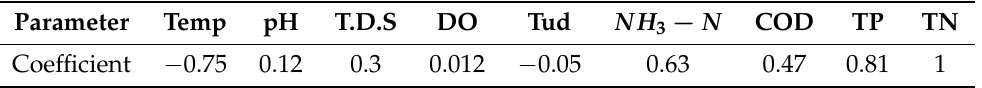
Table 2. Correlation coefficient between water parameters and